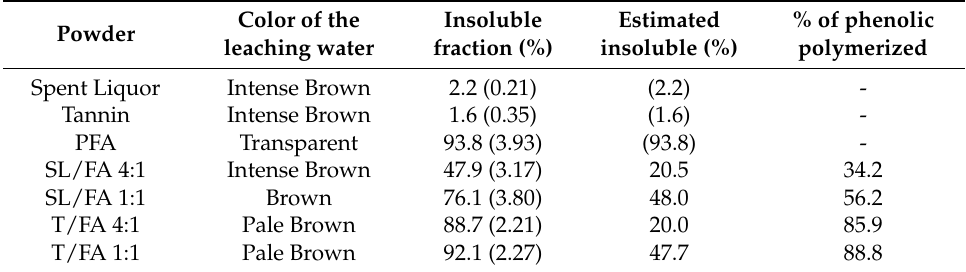
Table 3. Insoluble fraction, estimated insoluble, phenolic insoluble, and phenolic polymerized expressed in %.